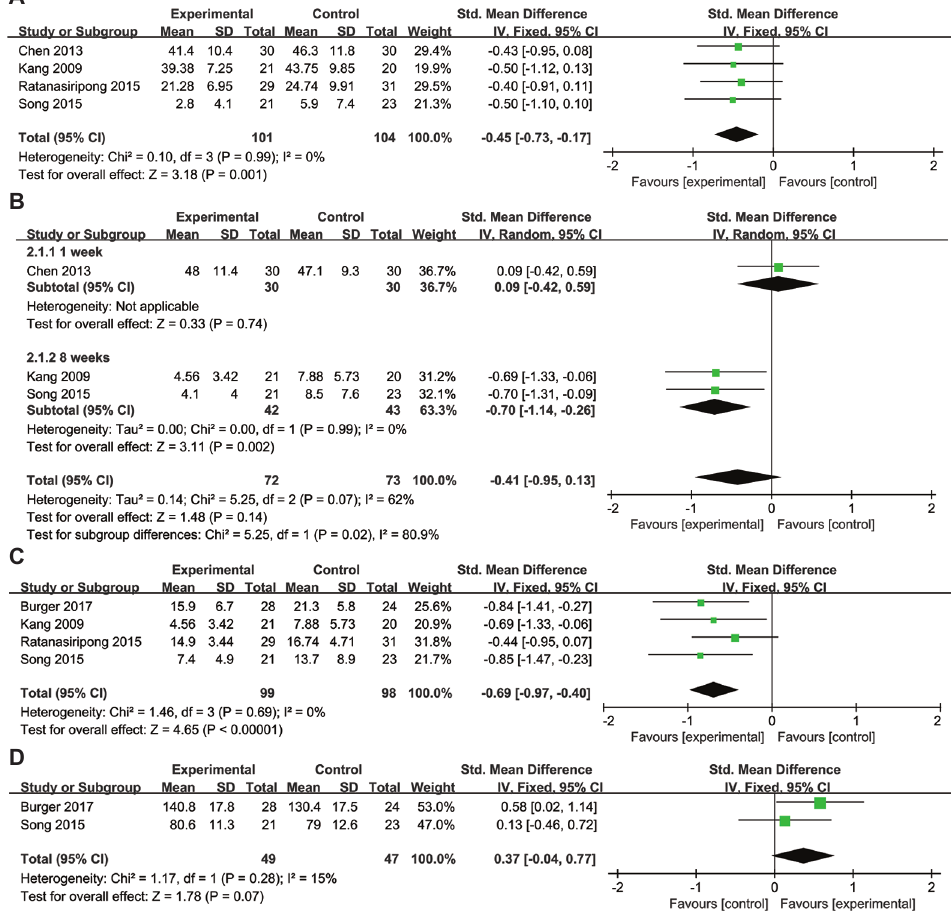
Figure 3. Effect of mindfulness meditation on anxiety, depression, stress and mindfulness. A. Anxiety B. Depression C. Stress D.